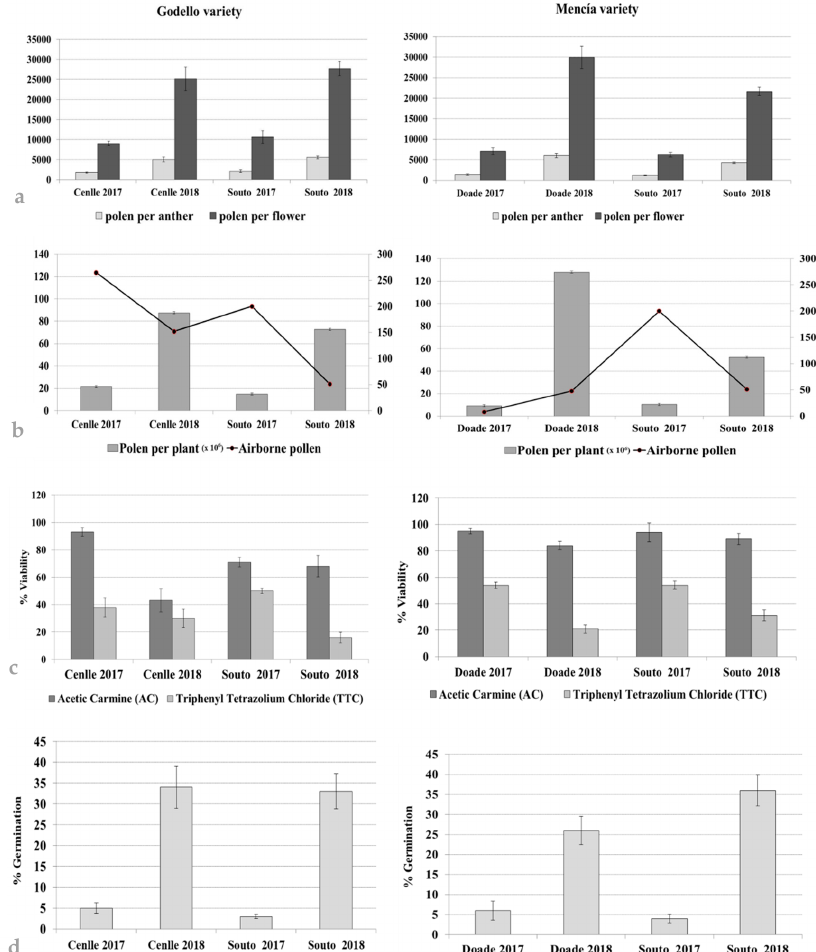
Figure 5. (a) Average values of pollen per anther and pollen per flower. (b) Average value of pollen Figure 5. ( a ) Average values of pollen per anther and pollen per flower. ( b ) Average value of pollen per plant (10 6 ) (left axis) and airborne pollen (right axis). (c) Percentage of pollen viability by means per plant (10 6 ) (left axis) and airborne pollen (right axis). ( c ) Percentage of pollen viability by means of of aceto-carmine (AC) and 2, 3, 5-triphenyl tetrazolium chloride (TTC). (d) Germination rates for Godello and Mencía varieties in the studied vineyards (standard error of the mean on each column). aceto-carmine (AC) and 2, 3, 5-triphenyl tetrazolium chloride (TTC). ( d ) Germination rates for Godello and Menc í a varieties in the studied vineyards (standard error of the mean on each